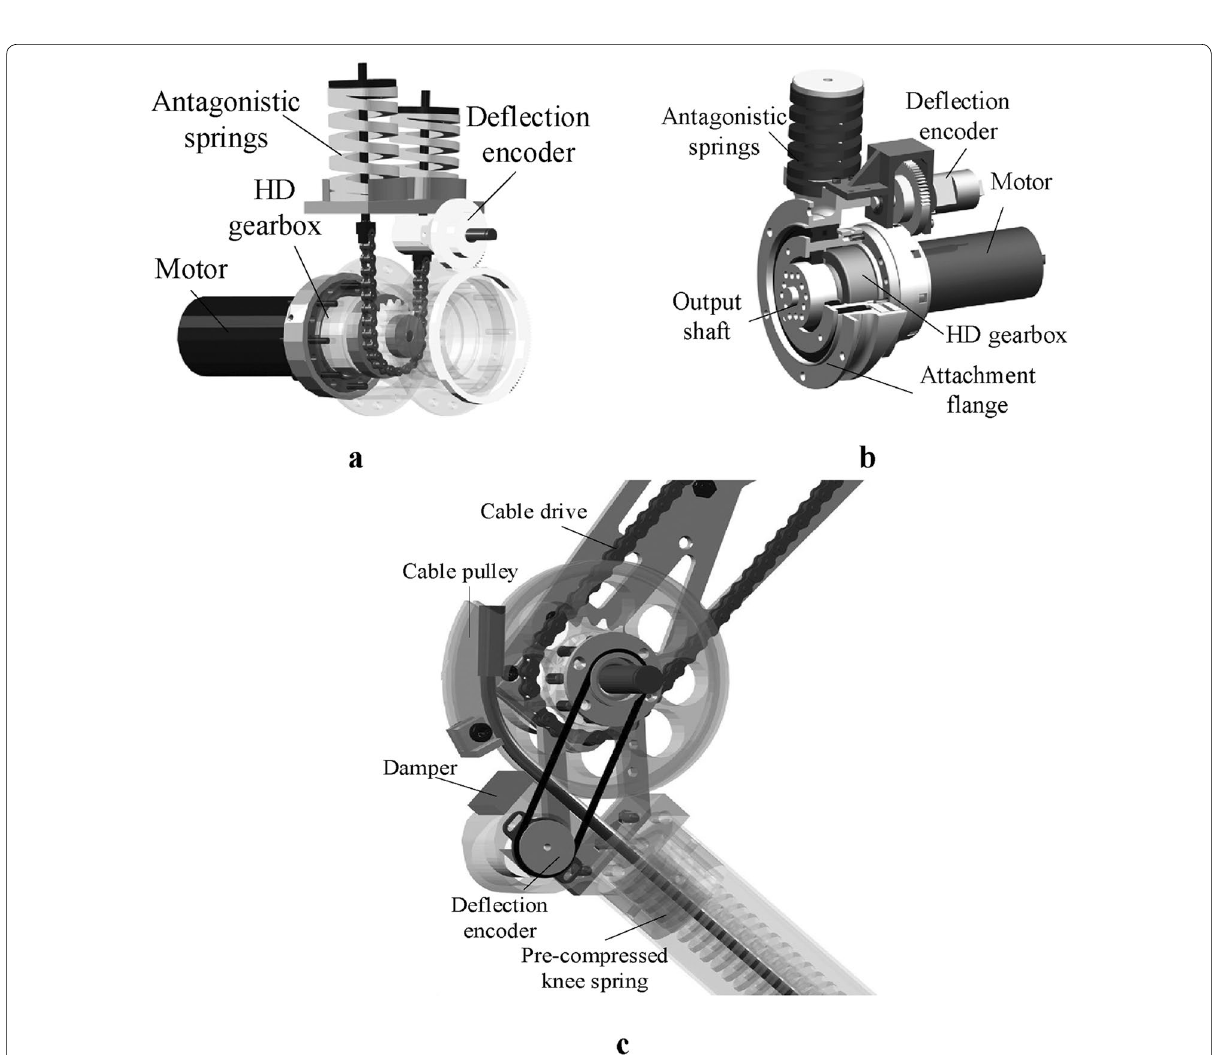
Figure 11 Compliant joints of ScarlETH [20, 44]: a HAA joint; b HFE & KFE joints; c chain drive connecting to the knee